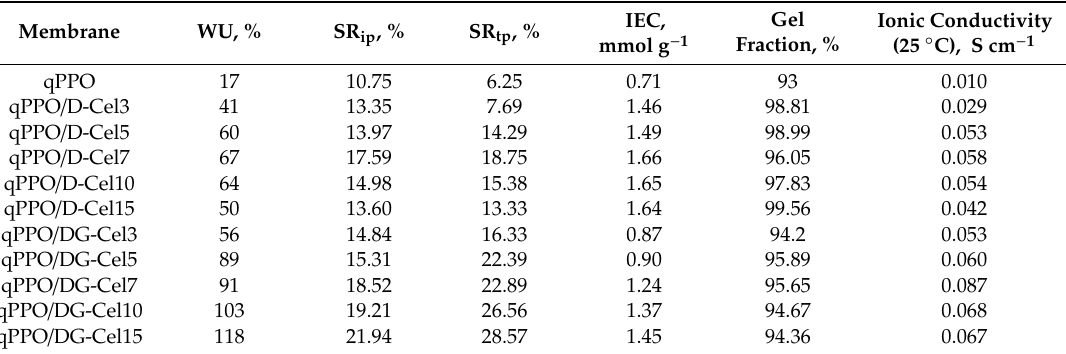
Table 1. Characteristics of the